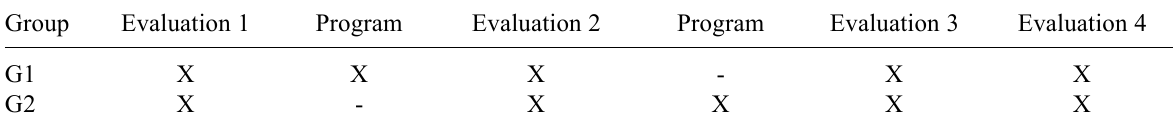
Delineation Stages of the Multiple Probe Design with Both of the Groups Involved in this Research